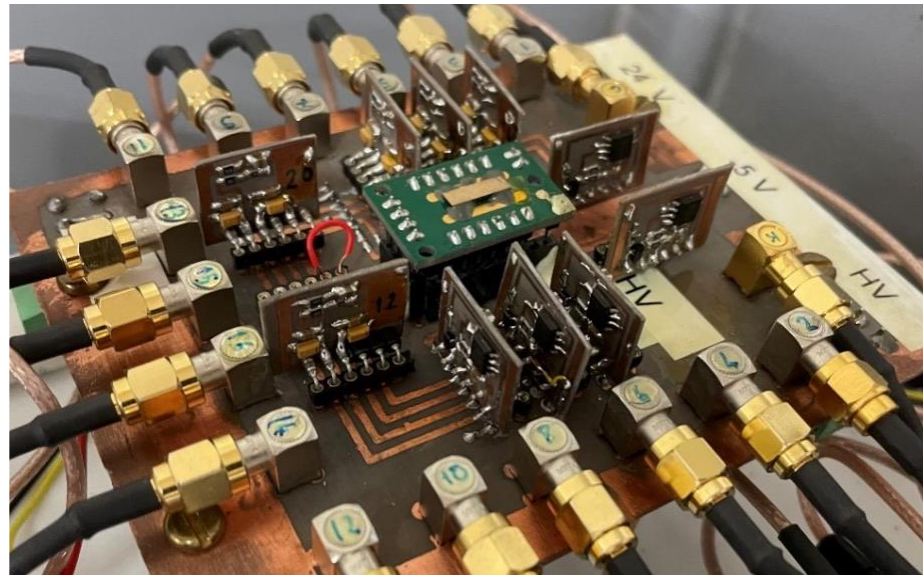
Figure 3. The B-VB CZT linear array detector coupled to the charge sensitive preamplifiers (CSPs).